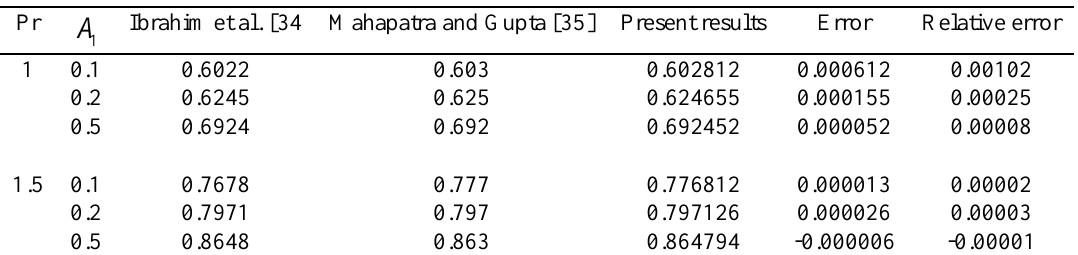
Table 3. Comparison of the numerical values of   0  for , A=0,n=1 , Pr=1, =0  , S=0,K   , Nt=0, Nb=0, R=0,Ec=0 . Pr A Ibrahim et al. [34 Mahapatra and Gupta [35] Present results Error Relative 1